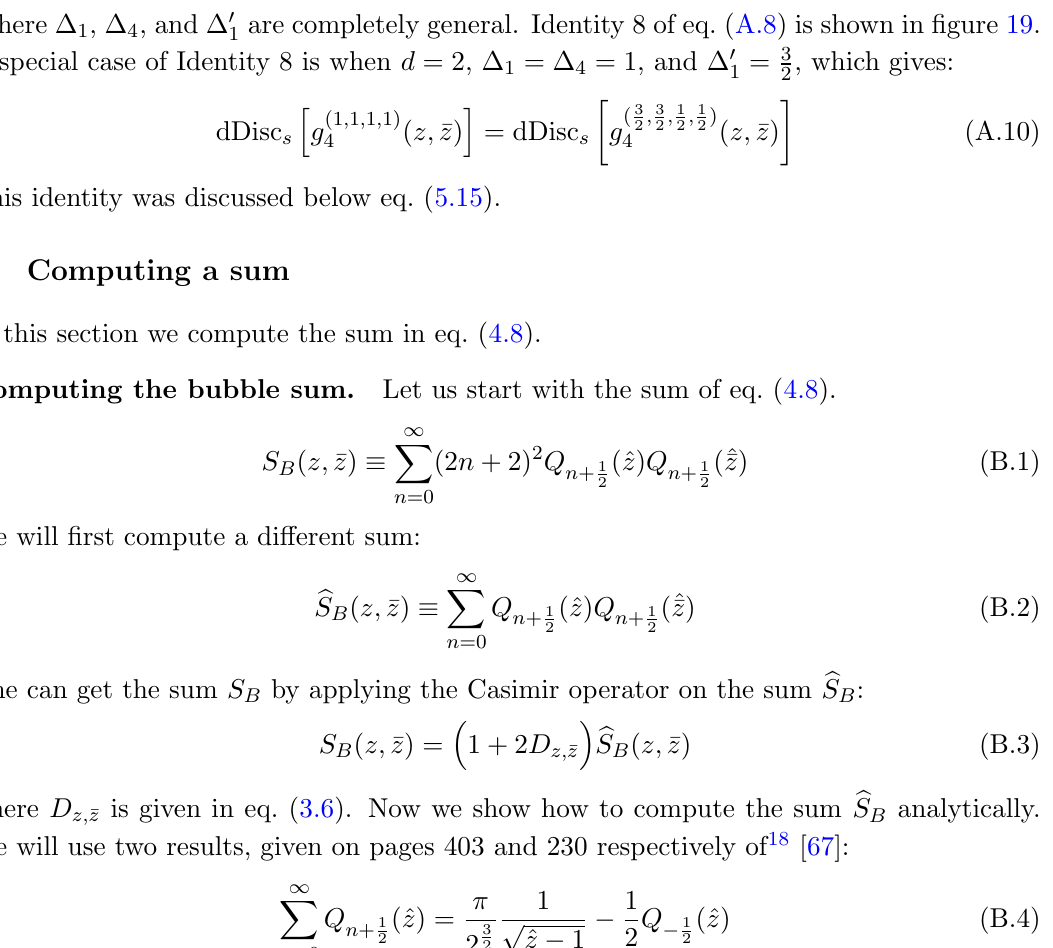
Figure 19 . Identity 8: a relation for the dDisc s of the 4-point function with di(cid:11)erent choices of the external scaling dimensions. (cid:1) 1 , (cid:1) 4 , and (cid:1) 0 are arbitrary. The blob 2-point function with end 1 points x 1 and x 2 is general, and the diagrams correspond to stripped